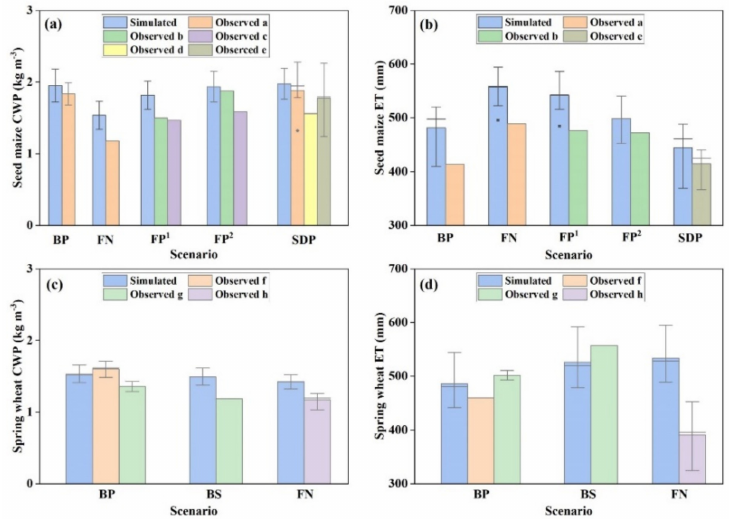
Figure 4. Comparisons between the observed and simulated seed maize ( a ) CWP and ( b ) ET and spring wheat ( c ) CWP and ( d ) ET under different scenarios. (BP, FN, FP, BS, and SDP present basin irrigation with plastic mulching, furrow irrigation with no mulching, furrow irrigation with plastic mulching, basin irrigation with straw mulching, and subsurface drip irrigation with plastic mulching, respectively. FP 1 and FP 2 present different coverage of plastic mulching, respectively. The observed values a to h are collected from a Zhang [73], b Zhao et al. [74], c Zhang et al. [75], d He et al. [76], e Zheng et al. [77], f Wang [78], g Ma et al. [59], and h Ma et al. [60].